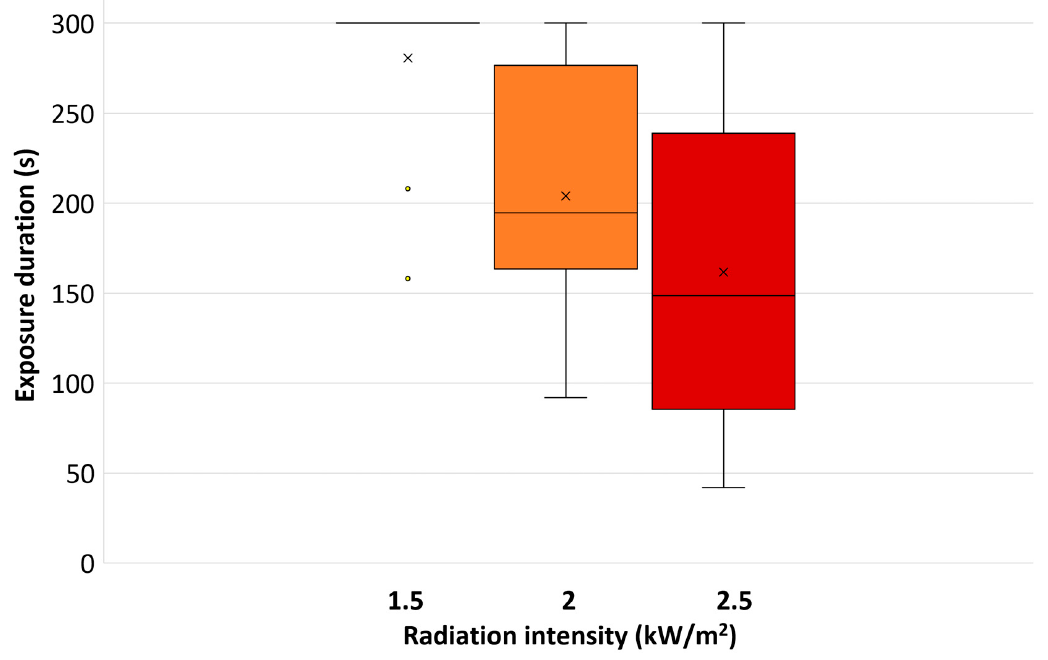
Figure 5. The median (horizontal line) and mean ( × ) exposure times with the standard deviation and the outliers ( ◦ ) at the different radiation intensities.